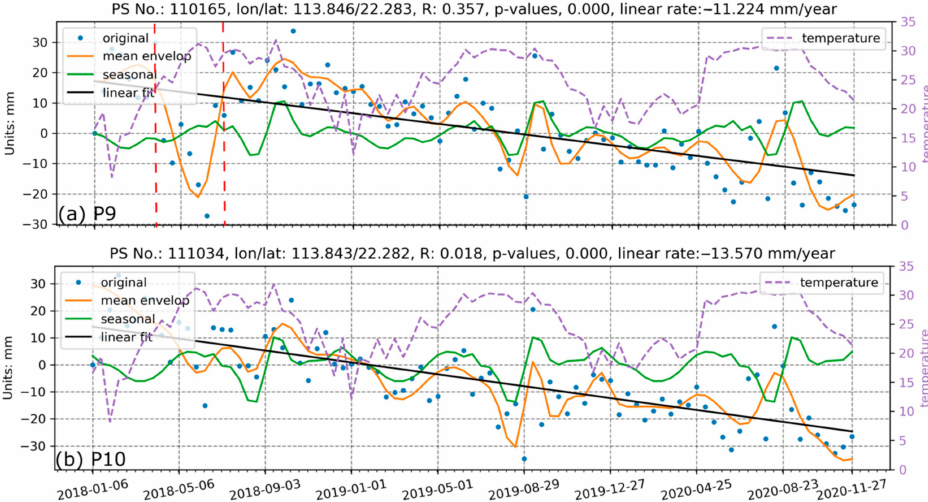
Figure 13. Time-series processing results of ( a ) P9 and ( b ) P10 at the northeast and south of the east man-made island. The red dashed lines indicate the period between April and June in